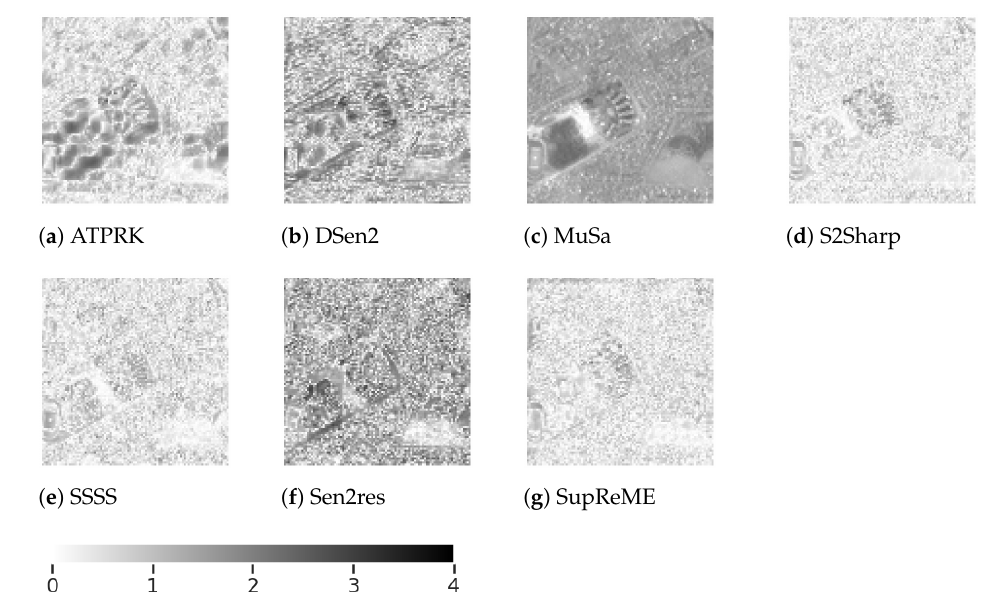
Figure 7. Absolute error map of Escondido crop, band B9, on log scale. Lower values are